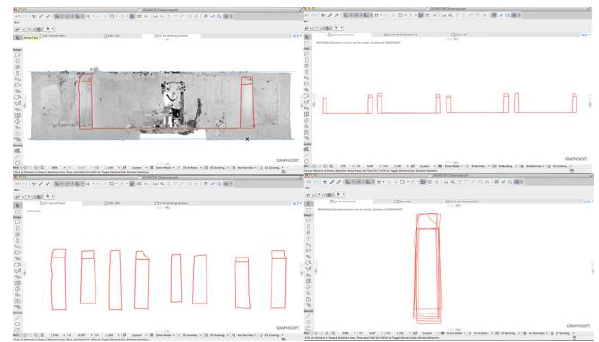
Fig. 9. The process of tracing the point cloud data profiles and creating the custom complex profiles for parametric wall